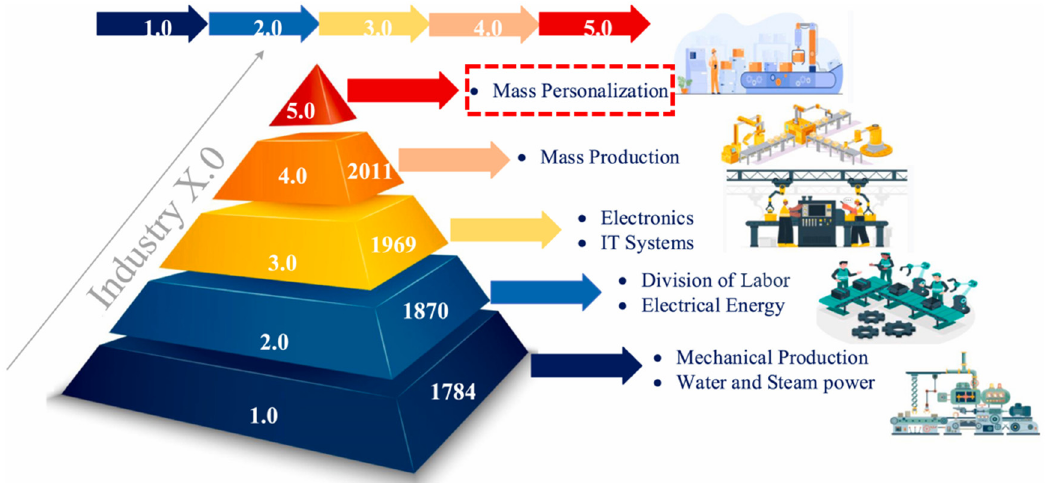
Figure 1. The development of industry from 1784 to the present with permission from [13], 2022,